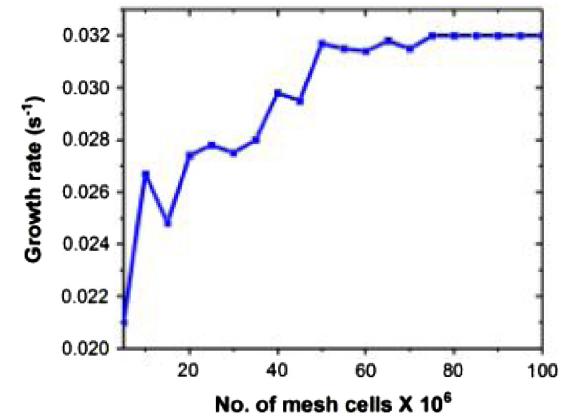
FIG. 27. Variation of the number of secondary electrons in the SSR-C cavity as a function of time, for three different types of primary particle sources.